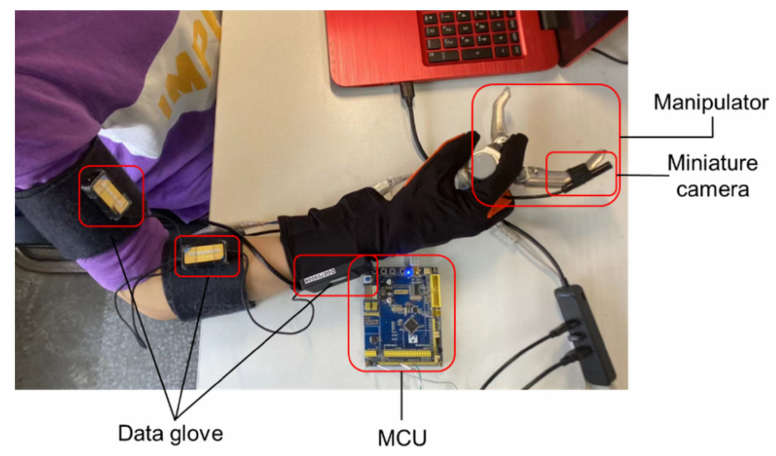
Figure 8. Experimental equipment.